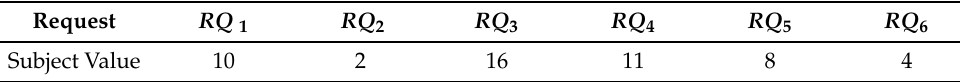
Table 5. Subject value for each